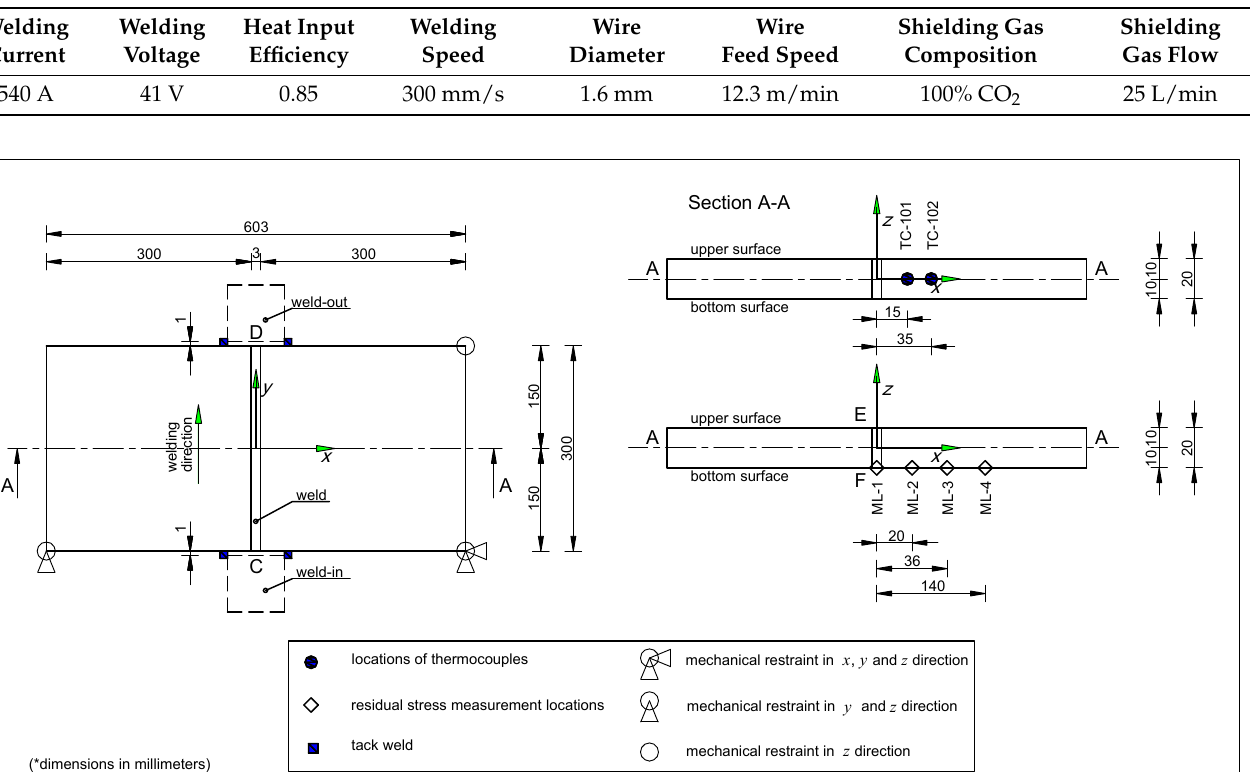
Table 1. Main welding parameters.